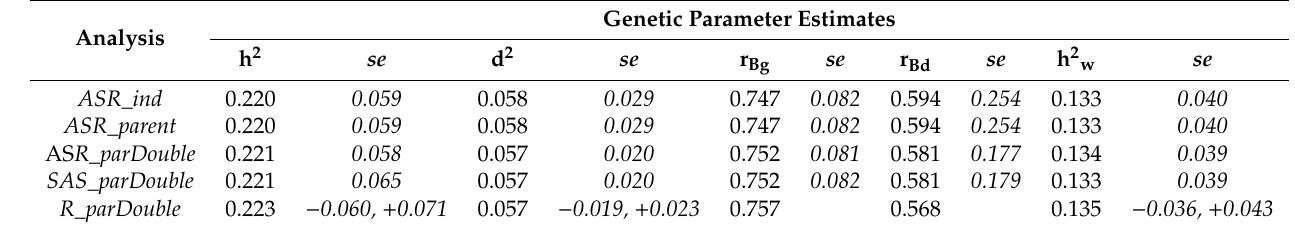
Table 3. Estimated genetic parameters 1 and standard errors 2 from five linear mixed models 3 for a simulated full-sib progeny dataset with 40 parents, 80 families from an unbalanced mating design, 4 tests, and 25 trees / family /